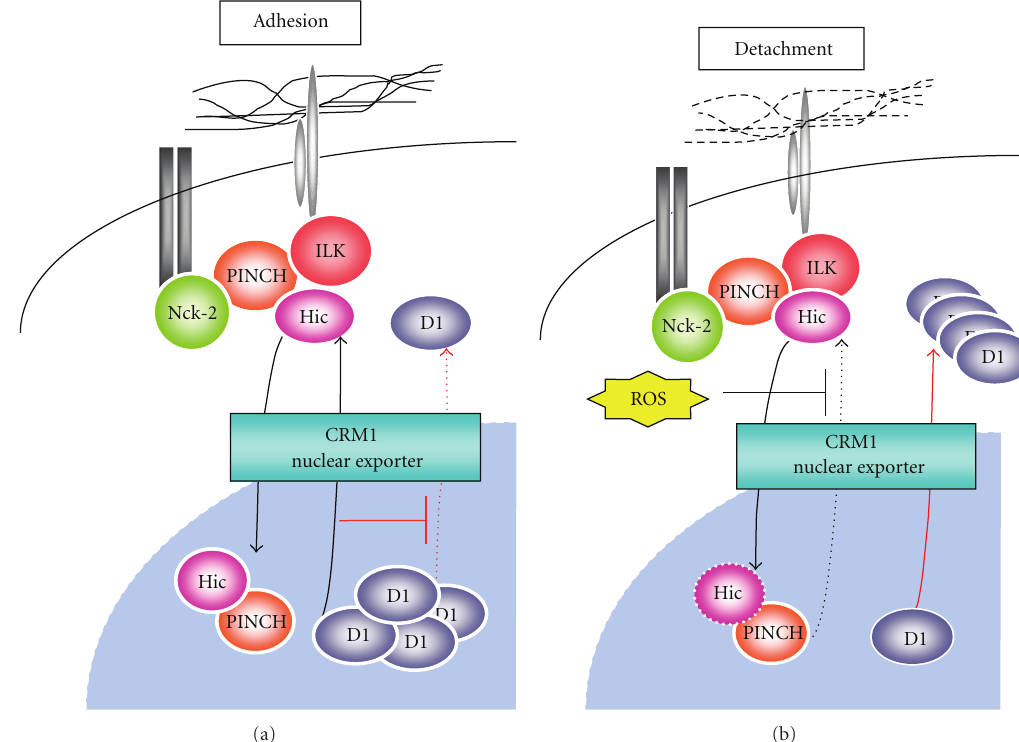
Figure 2: A mobile HIC-5/PINCH sca ff old regulating cyclin D1 subcellular localization in response to adhesion status. Cyclin D1 is retained in the nucleus in adherent cells such as mouse primary fibroblasts, C3H10T1/2 fibroblasts, and mammary epithelial NMuMG cells by the CRM1-dependent nuclear export of HIC-5 with the aid of PINCH, which counteracts the nuclear export of cyclin D1. The higher a ffi nity of HIC-5 for CRM1 favours the export of HIC-5. In detached cells, the nuclear export of HIC-5 is inhibited by elevated levels of ROS, and cyclin D1 is actively transported out of the nucleus, which results in a decrease in its nuclear localization (see further details in